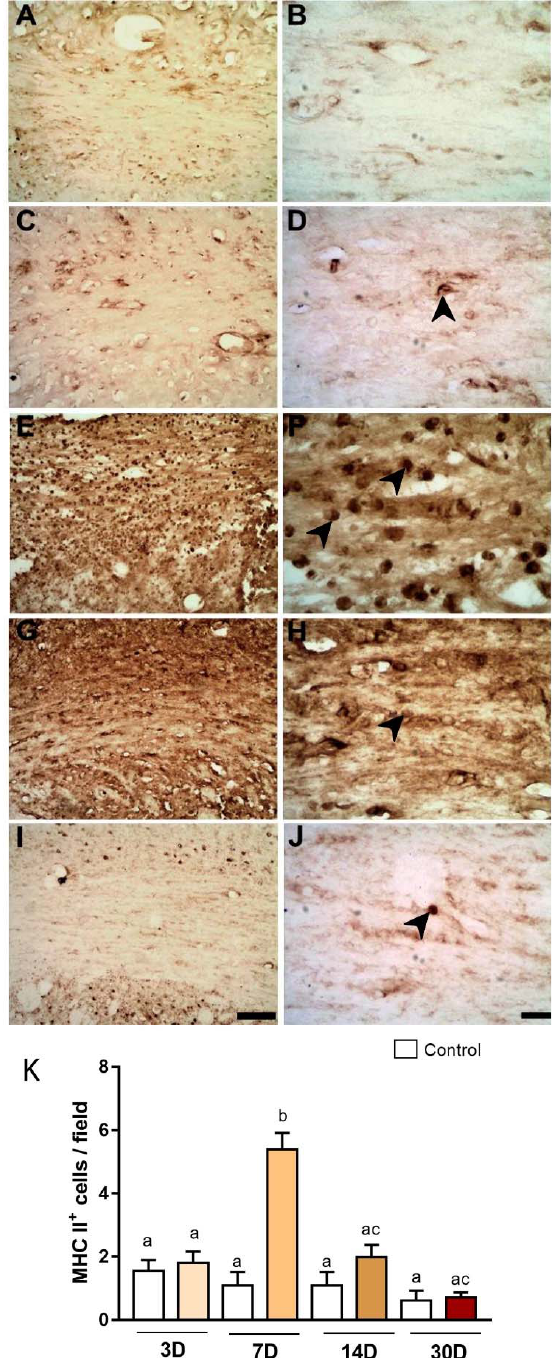
Figure 3. Increased immunoreactivity for MHC-II in the CC after focal striatal ischemia. Photomi- crographs represent control animal injected with sterile saline ( A , B ) or ischemic animals injected with ET-1 at 3 ( C , D ); 7 ( E , F ); 14 ( G , H ); and 30 ( I , J ) PLDs. Maximum MHC-II immunoreactivity was present at 7 days ( E , F ), which has been confirmed by quantitative analysis ( K ). The results of quantitative analysis ( K ) are expressed as mean ± standard error of the mean (SEM). One-way ANOVA with Tukey’s post-hoc test ( p < 0.05). Similar overwritten letters did not show significant statistical differences. Left-sided photomicrographs in lower magnification with a scale bar of 20 µ m, and right-sided ones, with higher magnification with a scale bar of 100 µ